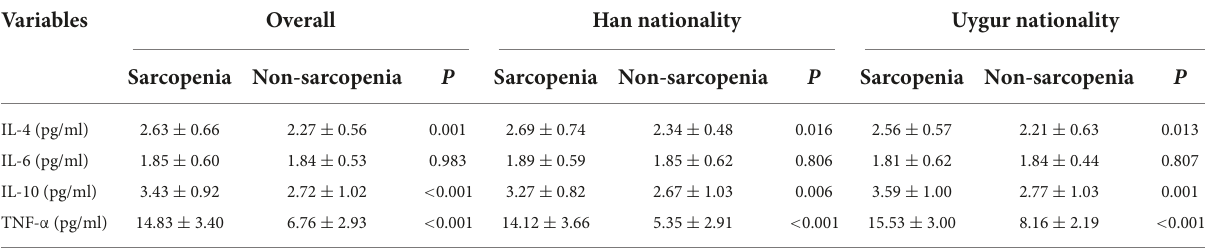
TABLE 2 Inflammatory cytokines levels in difference nationality between sarcopenia and non-sarcopenia group.